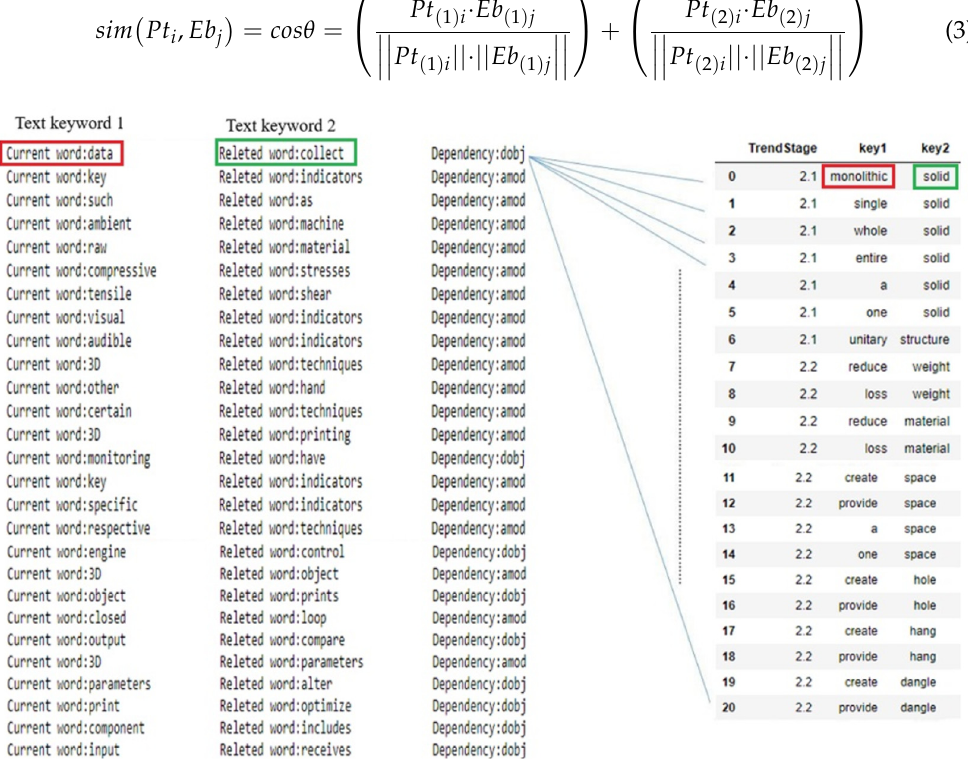
Figure 5. Calculation illustration between patent text keywords and dictionary keywords.